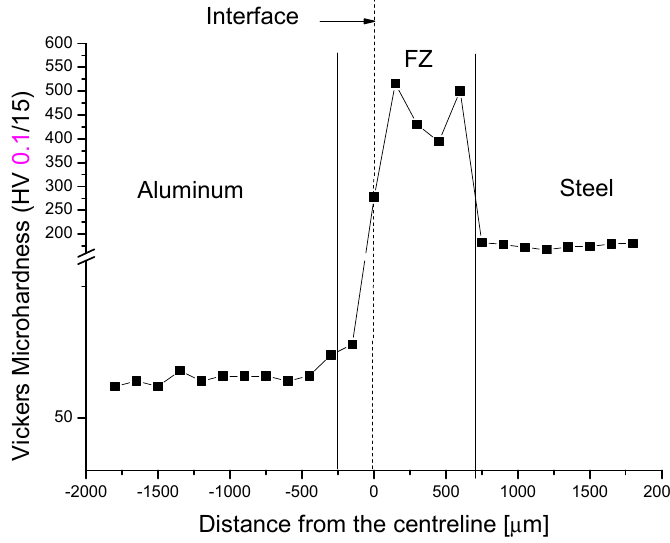
Figure 15. Cross weld section microhardness profile for the laser offset welding.